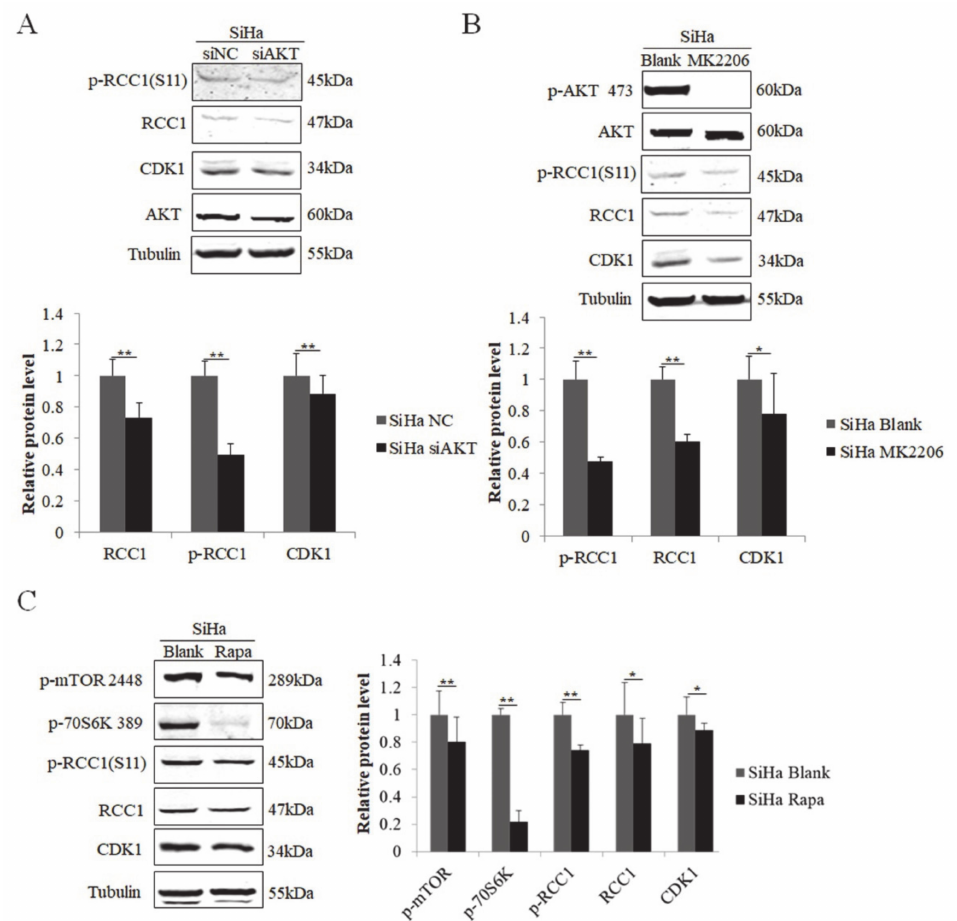
Figure 6. Phosphorylation of RCC1 S11 was increased by the PI3K/AKT/mTOR pathway in SiHa cells. ( A ) Expressions of RCC1, p-RCC1(S11), CDK1, AKT in SiHa cells with AKT knockdown was measured by Western blot. ( B ) Western blot analysis of p-AKT 473, AKT, p-RCC1(S11), RCC1, CDK1, in SiHa cells treated with MK2206. ( C ) p-mTOR 2448, p-70S6K 389, p-RCC1(S11), RCC1, CDK1 protein levels in SiHa cells treated with Rapa were measured by Western blot. Data shown are representative of 3 biological replicates. * p < 0.05; ** p <